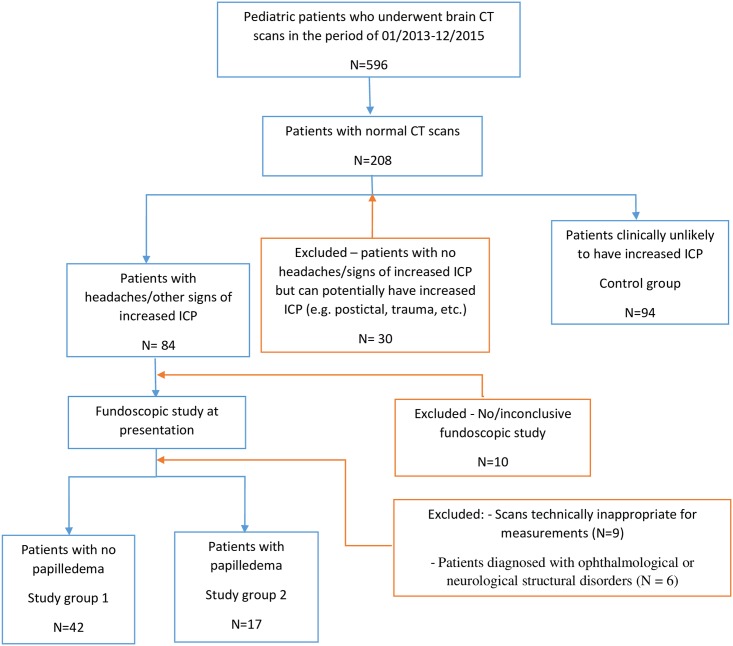
Study population.